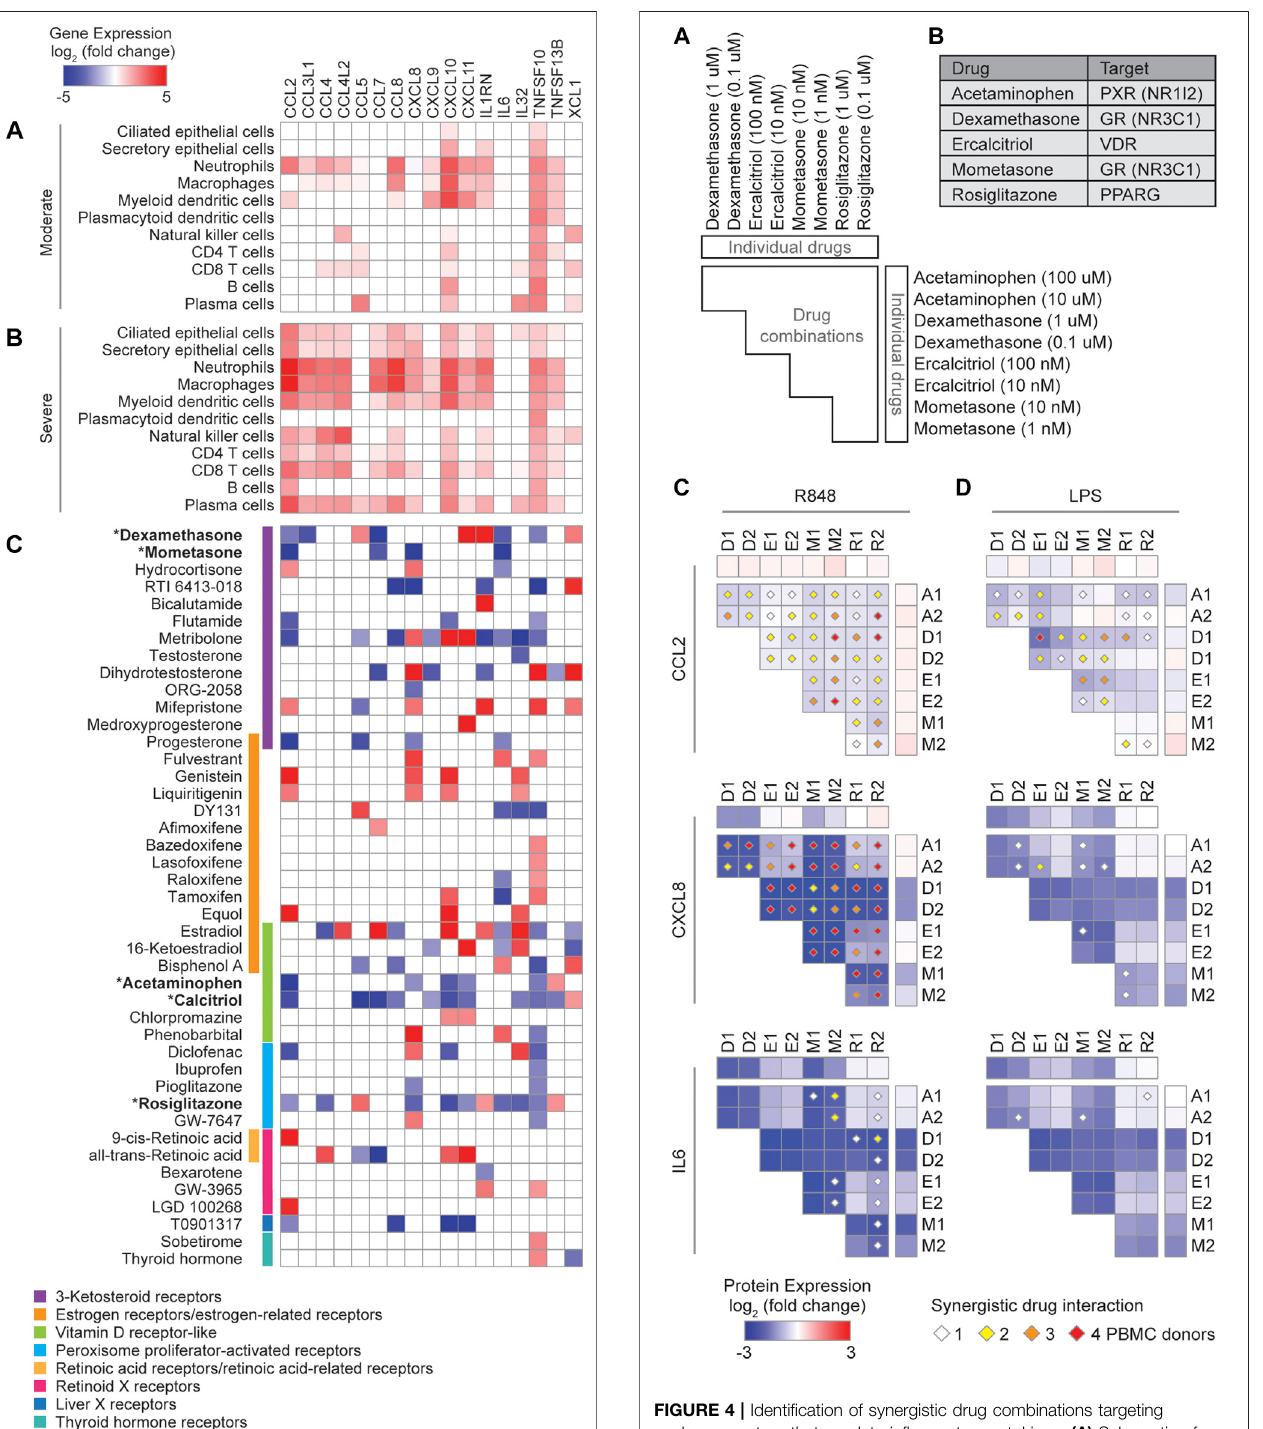
FIGURE 4 | Identi fi cation of synergistic drug combinations targeting nuclear receptors that regulate in fl ammatory cytokines. (A) Schematic of experimental design to test 40 drug combinations. (B) Drug NR TF targets. (C,D) Heatmaps showing the average log 2 (fold change) cytokine productionacrossfourPBMCdonorstreatedwiththeindicateddrugs,relative to PBMCs not treated with the indicated drugs, and stimulated with (C) R848 or (D) LPS.Diamondsindicate synergisticdruginteractions,asdetermined by the coef fi cient of drug interaction, observed in 1 (white), 2 (yellow), 3 (orange), or all 4 (red) PBMC